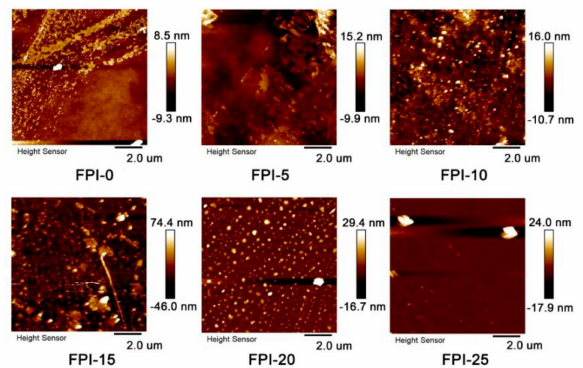
Figure 12. Atomic force microscopy (AFM) images of PI composite films with the surface roughness values at the scale of 2.0 µ m.